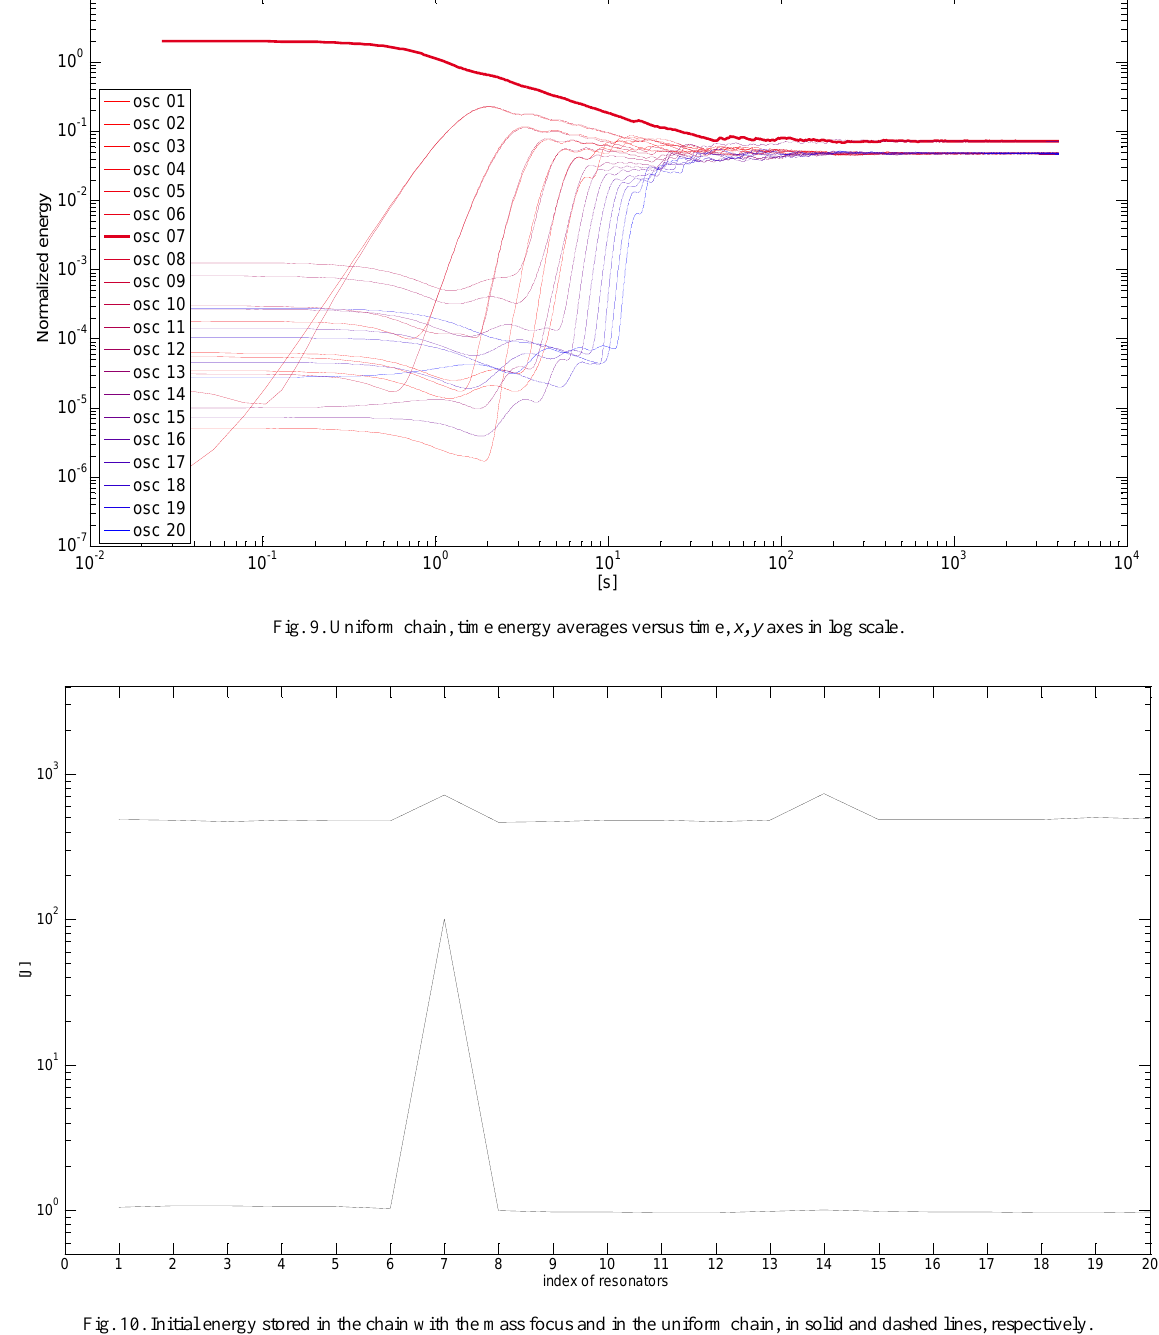
Fig. 10. Initial energy stored in the chain with the mass focus and in the uniform chain, in solid and dashed lines, respectively.